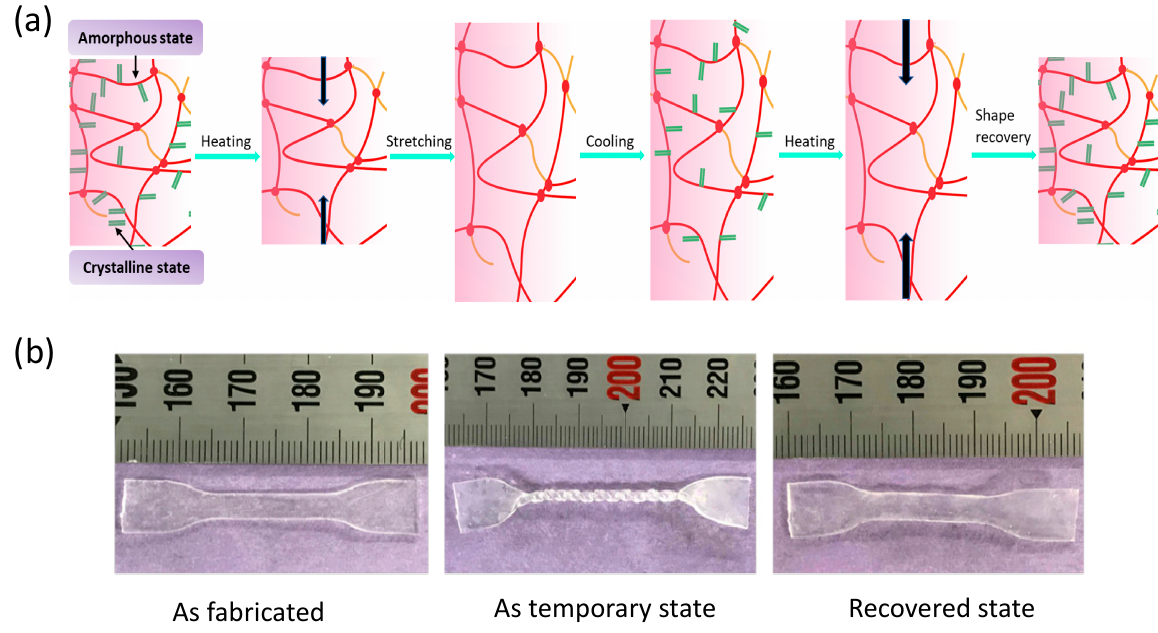
Figure 1. ( a ) Illustration on shape memory property of shape memory gel (SMG), ( b ) demonstration of shape memory behavior of 3D printed SMGs.